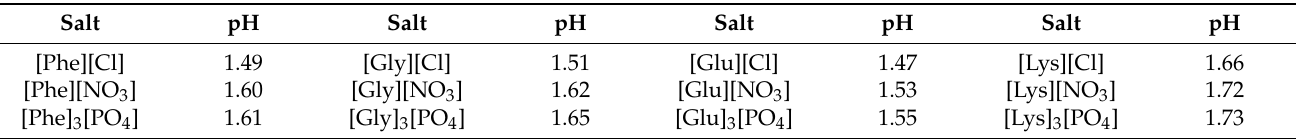
Figure 1. Synthesis of [AA][X]. AA = Gly (glycine), Phe (phenylalanine), Thr (threonine), Glu (glutamic acid), and Lys (lysine). X = Cl − , NO 3 − , 1/3 PO 43 − . Table 2. pH values for 0.3 mol/L aqueous solutions of the AA-ILs.